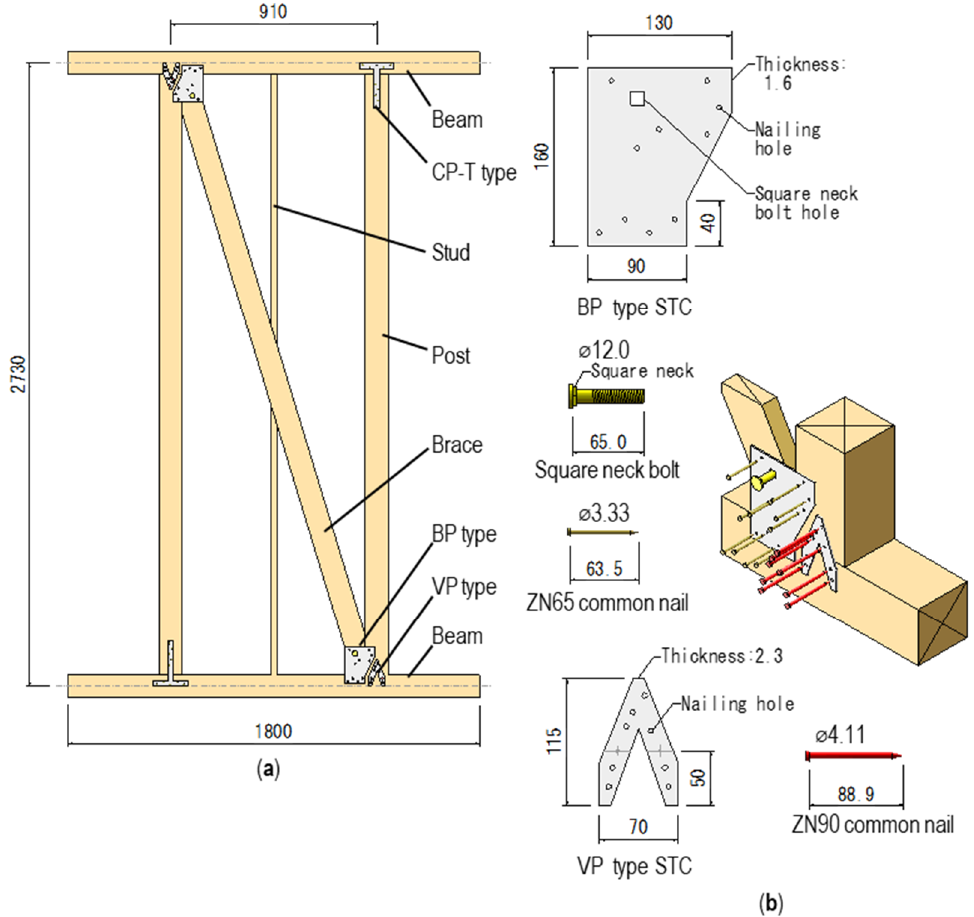
Figure 8. VP-and-BP-type full-scale in-plane cyclic test specimen: ( a ) overall view of the specimen; ( b ) detail of the post-beam-brace connection with VP-type and BP-type STCs; detail of post-beam connection with CP-T-type STC is the same as in the pullout test specimen; dimensions in mm. Table 2. Density and water absorption of the timbers for the full-scale in-plane cyclic test specimens.